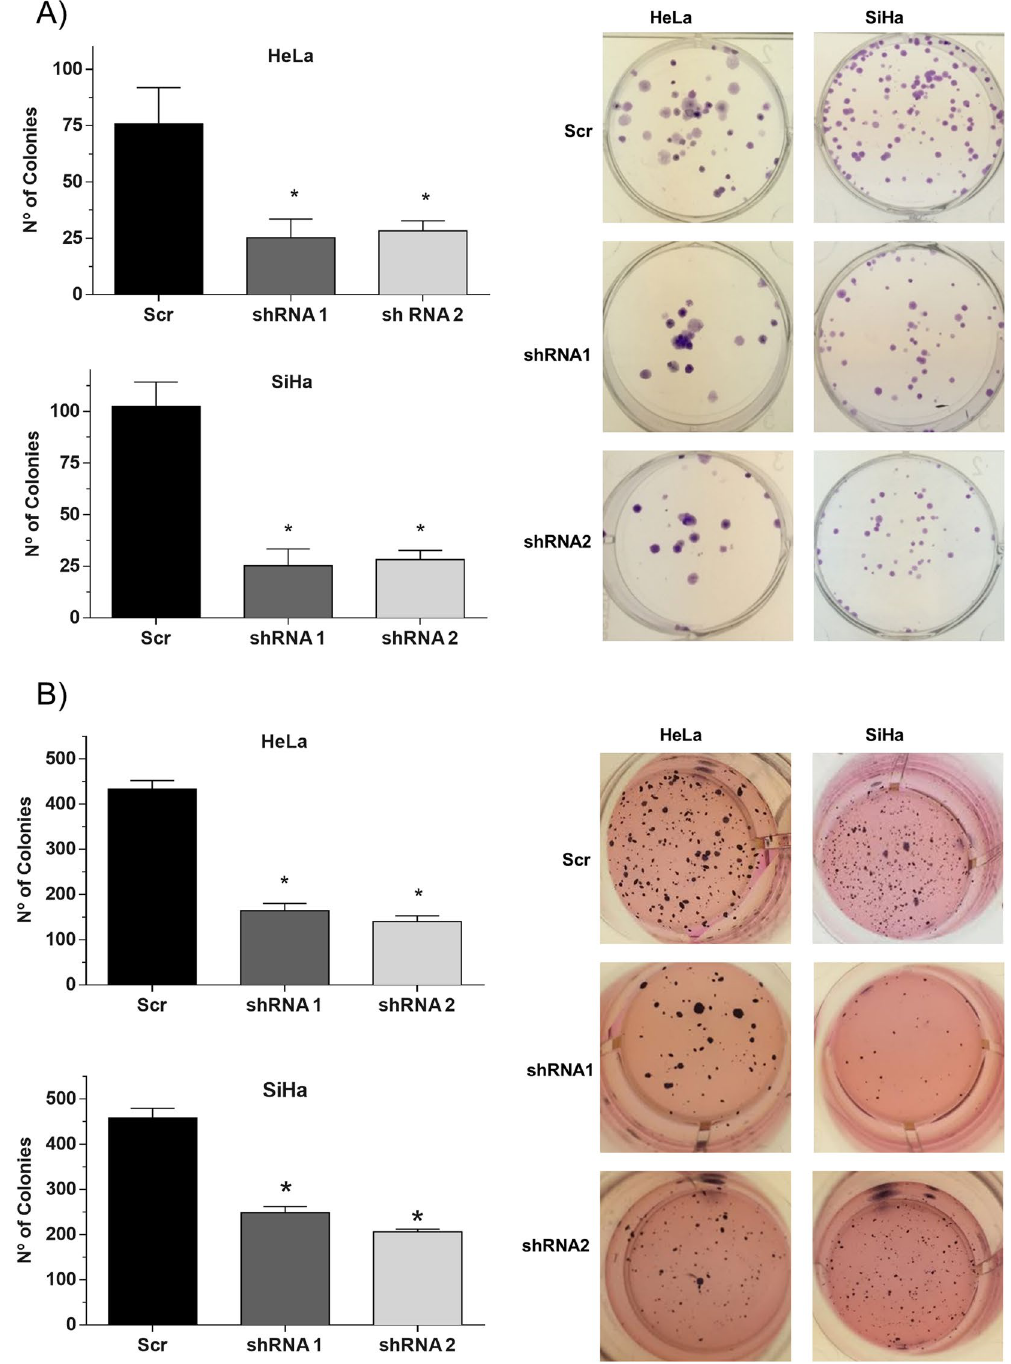
Figure 5. HMGB1 silencing affects the clonogenic potential of cervical cancer-derived cells. A lentiviral shRNA (MISSION ® ) was used specifically to silence HMGB1 in cervical cancer cell lines. After antibiotic selection, cells were seeded for colony formation assays. ( A ) Inhibition of colony formation in low-density assay. Cells were seeded in 6-well plates (100 cells/well); after 14 days, cells were fixed and the number of colonies was counted. ( B ) Inhibition of colony formation on soft agar in anchorage-independent growth assay. Cells were seeded in 24-well plates coated with agarose (500 cells/well). After 30 days, colonies were stained with MTT and counted. (Student’s t test, p ≤